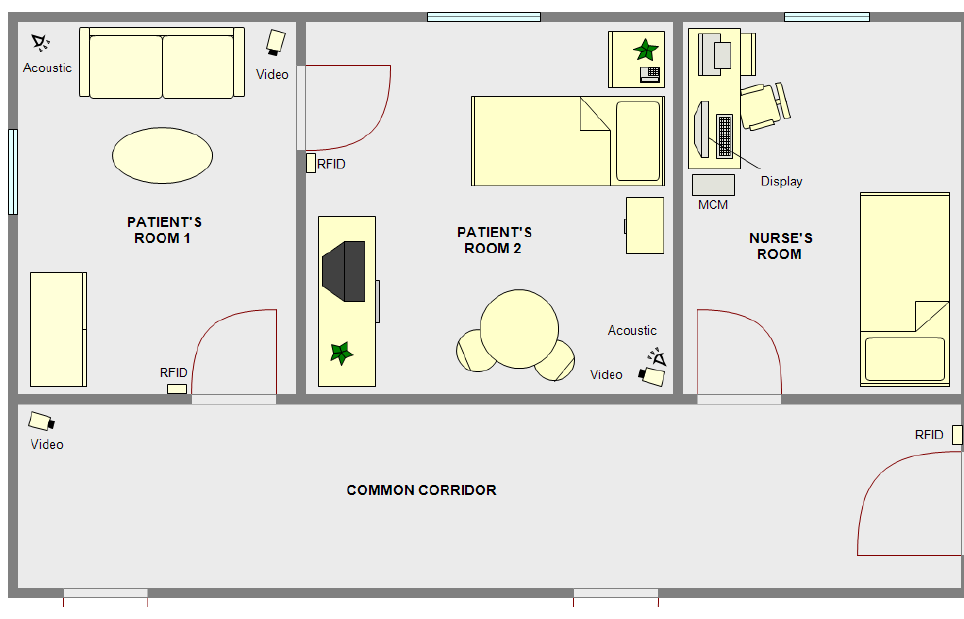
Figure 2. Example scenario of nursing home case of